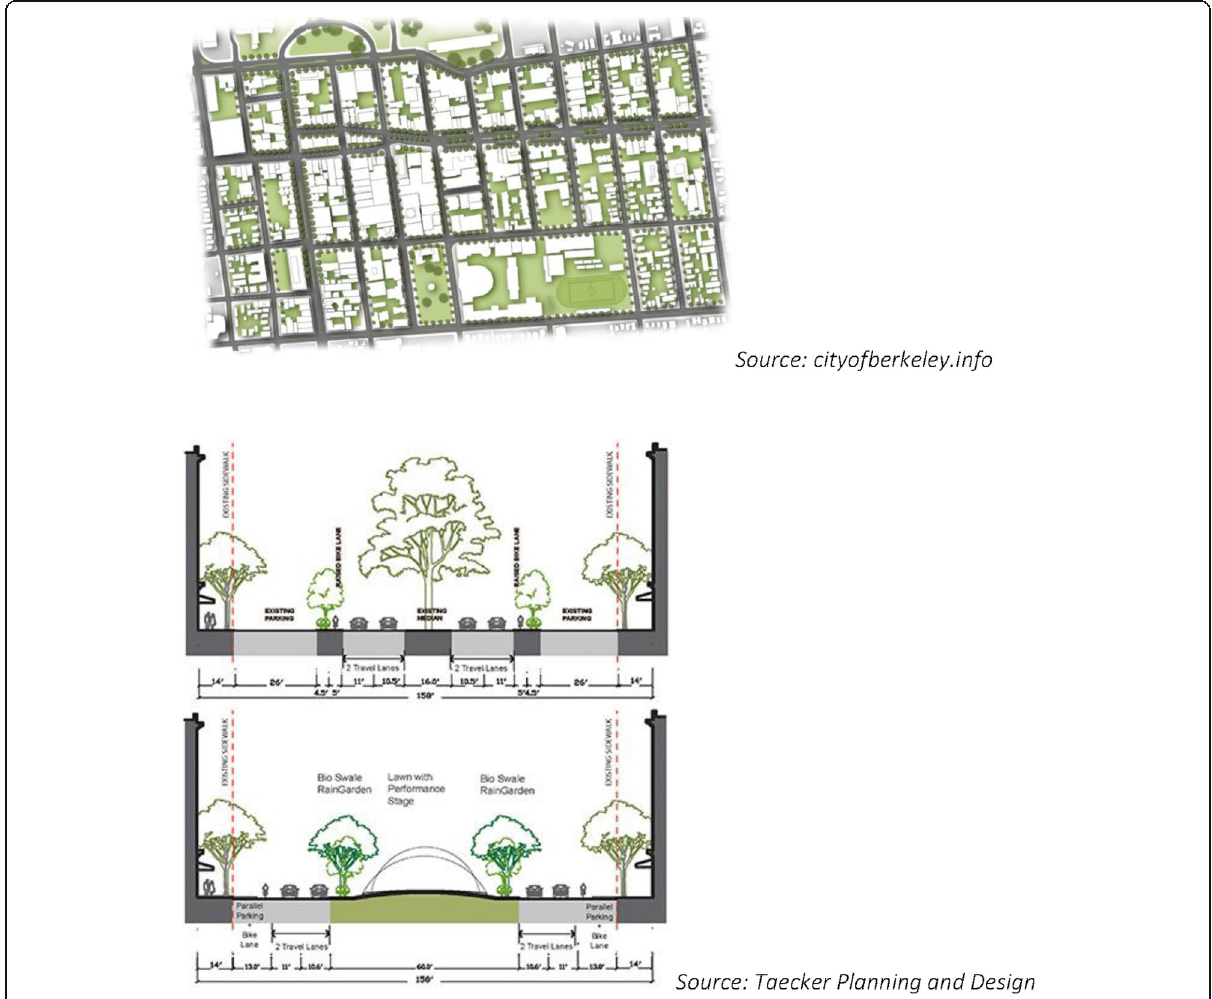
Fig. 2 SOSIP masterplan and section of street design integrating greeneries and multiple